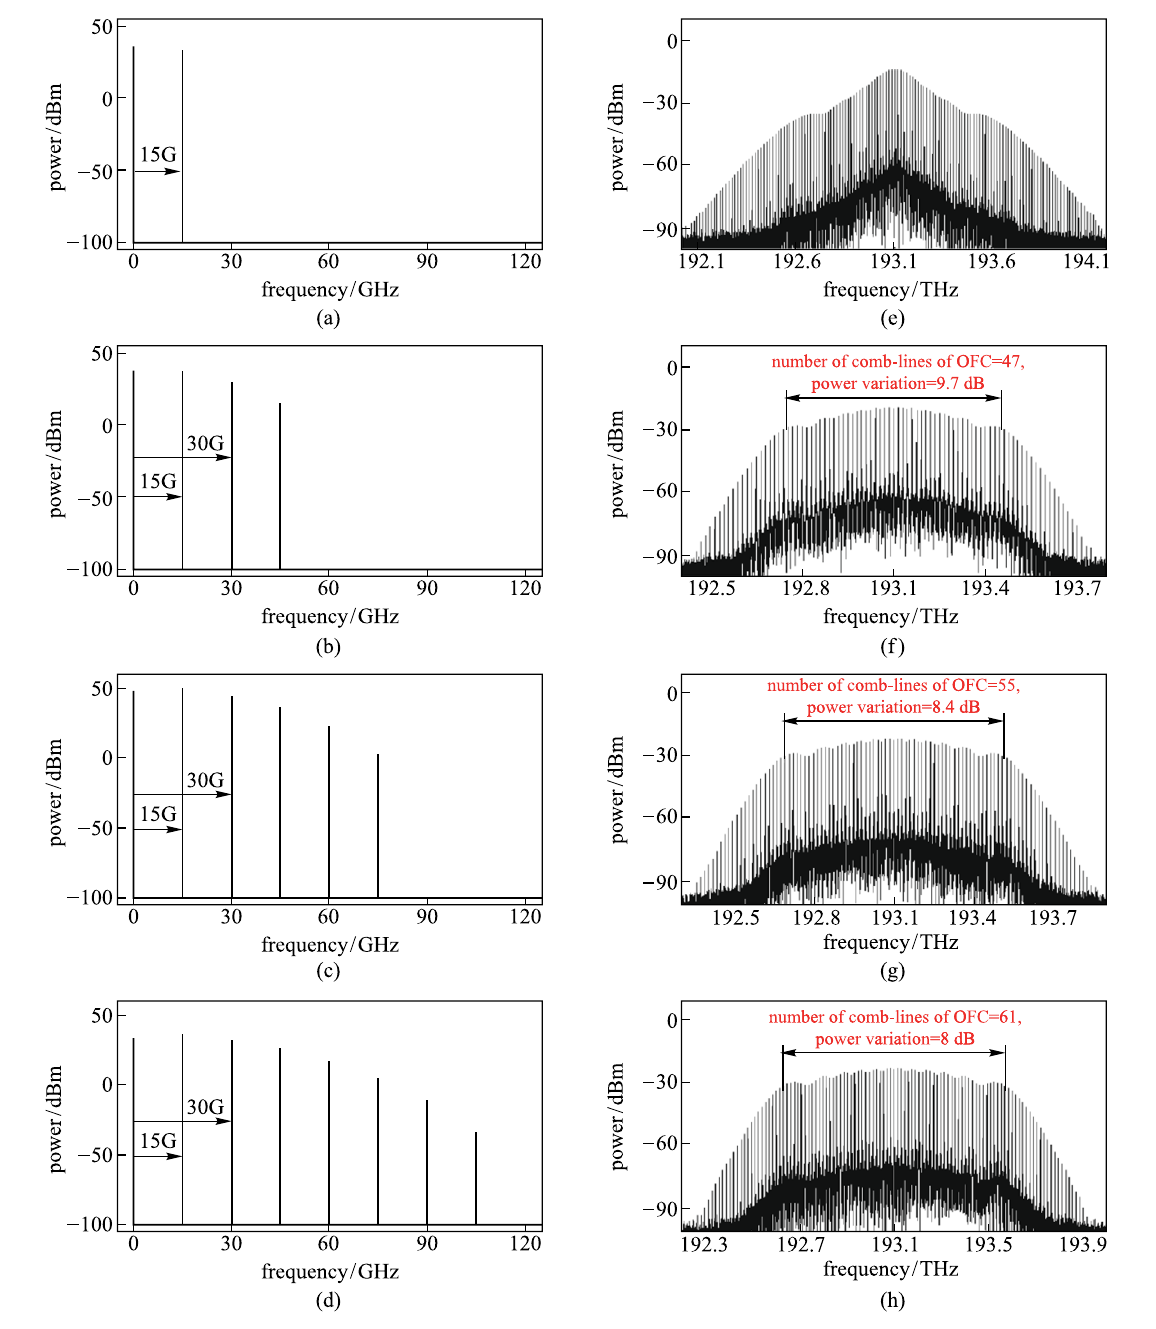
Fig. 2 Influence of varying the number of multiplication times of the RF source signal on the generated OFC. a – d The frequency spectrum for 2nd, 6th, 10th, 14th power of the RF source signal, respectively. e – h The corresponding optical spectra generated by using the n th power of the RF source signal as the modulation signal of the